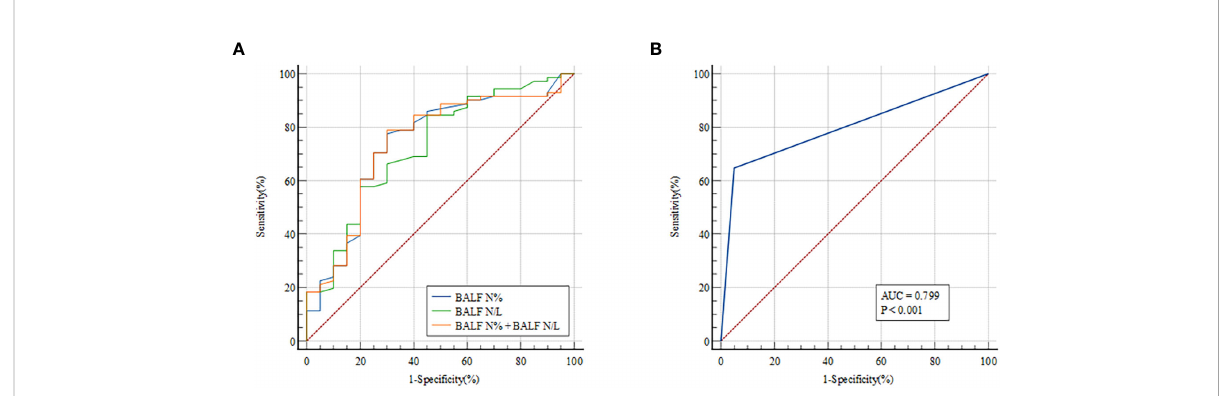
FIGURE 2 ROC curves for predicting PNID with single measurements. AUCs were 0.739 (95% CI 0.636 – 0.825) for BALF N% (A) , 0.727 (95% CI 0.624 – 0.815) for BALF N/L (A) , 0.742 (95% CI 0.640 – 0.828) for BALF N% combined with BALF N/L (A) , and 0.799 (95% CI 0.702 – 0.876) for BALF mNGS (B) . AUC, area under the curve; BALF, bronchoalveolar lavage fl uid; mNGS, metagenomic next-generation sequencing; N, neutrophils; N/L, ratio of neutrophils to lymphocytes; PNID, pulmonary non-infectious disease; ROC, receiver operating